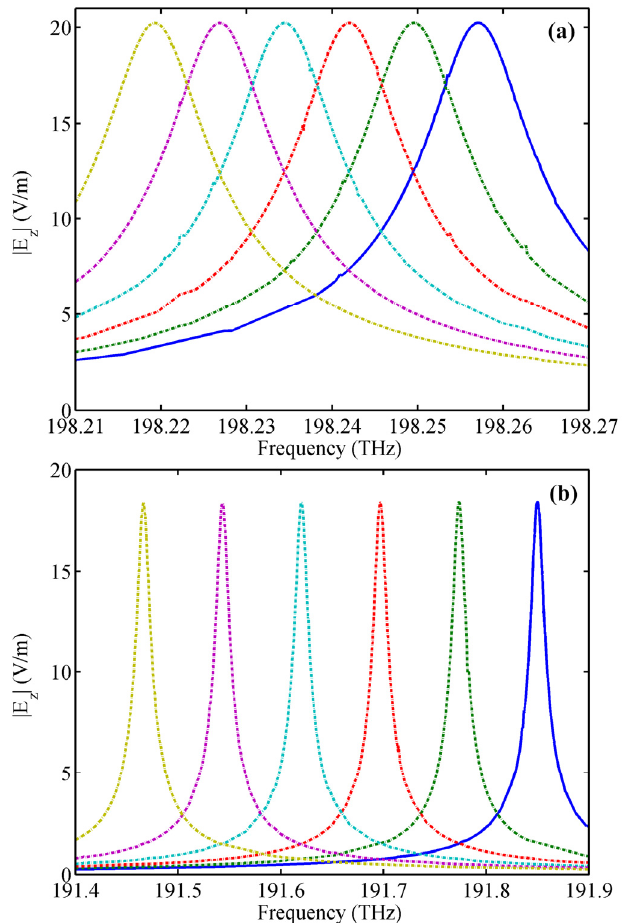
Figure 5. Resonant frequency spectrum of mode 27 with respect to the change of core ε . From left to right, the curves correspond to medium permittivity r 1.06, 1.08 and 1.1, respectively. (a) The microring sensor; (b) the NPM sensor. Thickness of the NPM layer is t = 0.09 μ m.